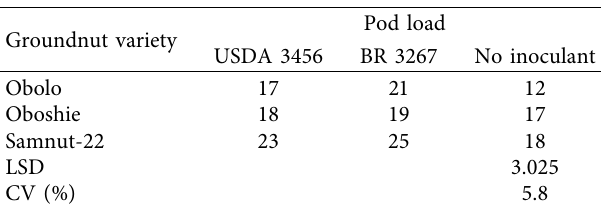
Table 4: Influence of rhizobium strains on pod loads of three groundnut varieties.